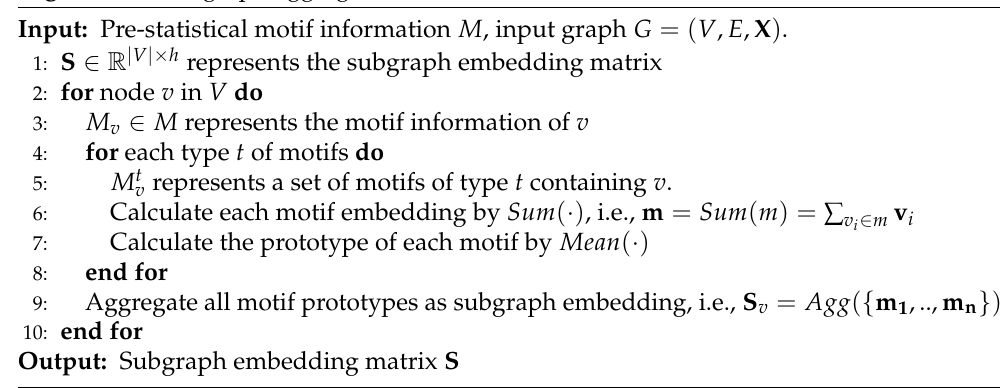
Algorithm 3 Subgraph aggregation.